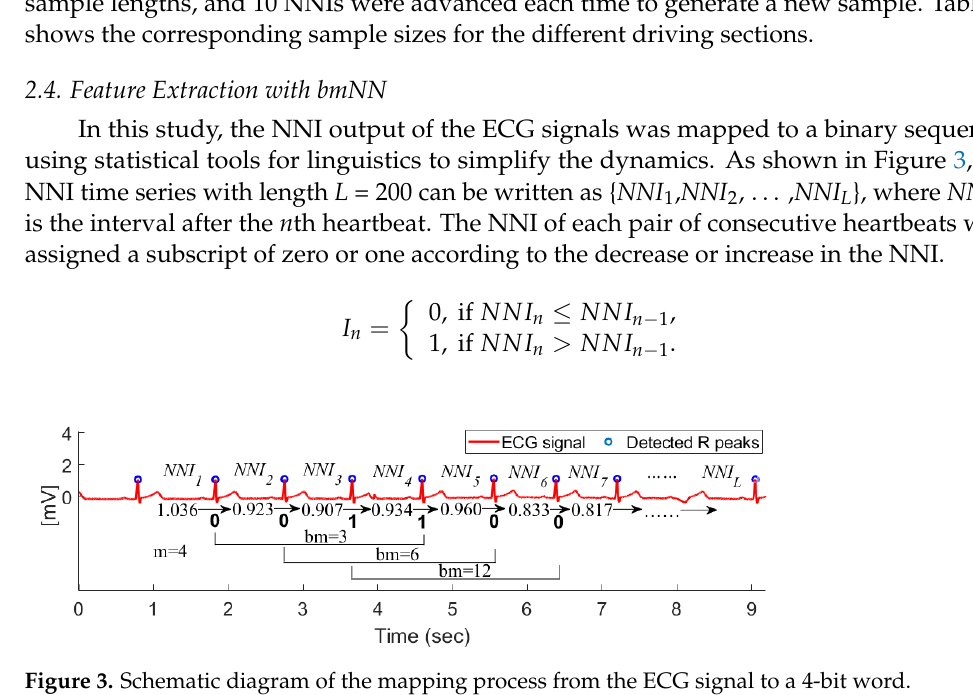
Figure 2. Block diagram of the recognition strategy for driving stress of the datasets in the drivedb database.